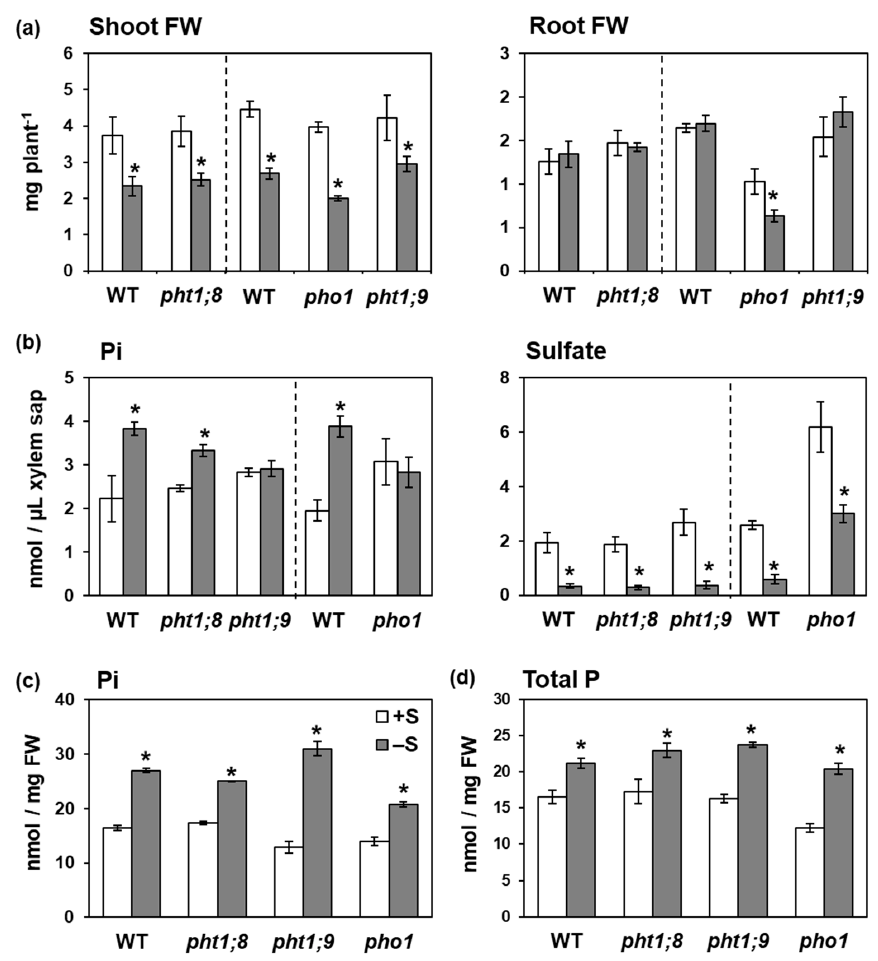
Figure 4. E ff ects of –S on Pi levels in xylem sap and shoots of wild-type (WT) plants and T-DNA insertion mutants of PHT1;8 , PHT1;9 , and PHO1 . ( a ) Fresh weight (FW) of shoots ( left ) and roots ( right ). ( b ) Pi levels in xylem sap were analyzed as described in Figure 3. ( c ) Pi and ( d ) total P concentrations in shoots were analyzed as described in Figure 1. Bars and error bars indicate mean ± SE ( n = 3). Dashed lines indicate separate experiments. Asterisks indicate significant di ff erences between + S and –S detected by Student’s t -test (* p < 0.05).